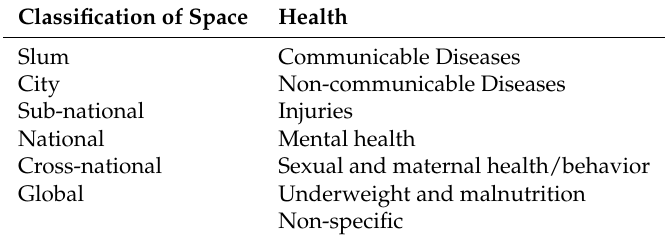
Figure 2. This figure shows the flowchart according to the adapted PRISMA guideline [52]. Table 1. The literature on health was classified using the following